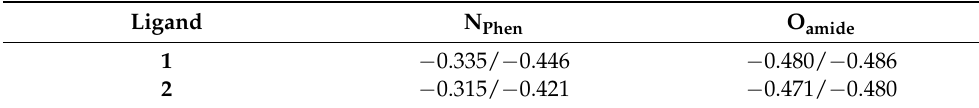
Figure 16. ESP maps of 1 and 2. Table 7. Merz-Kollman charges of N Phen and O amide of 1 and